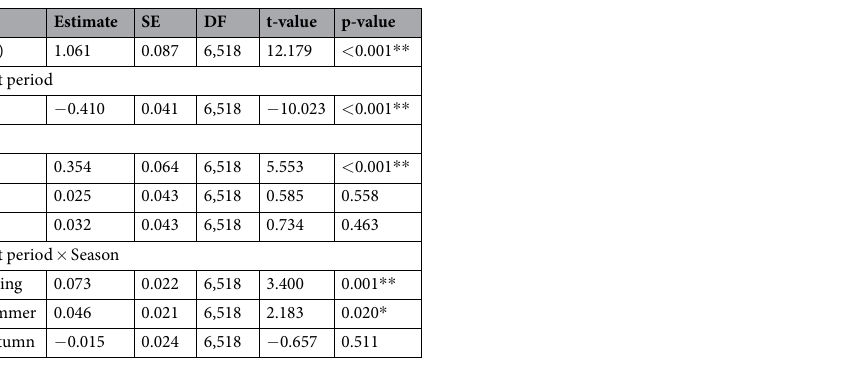
Table 2. Results of the linear mixed effects model testing the effect of the day/night period and the season on vertical movement activity